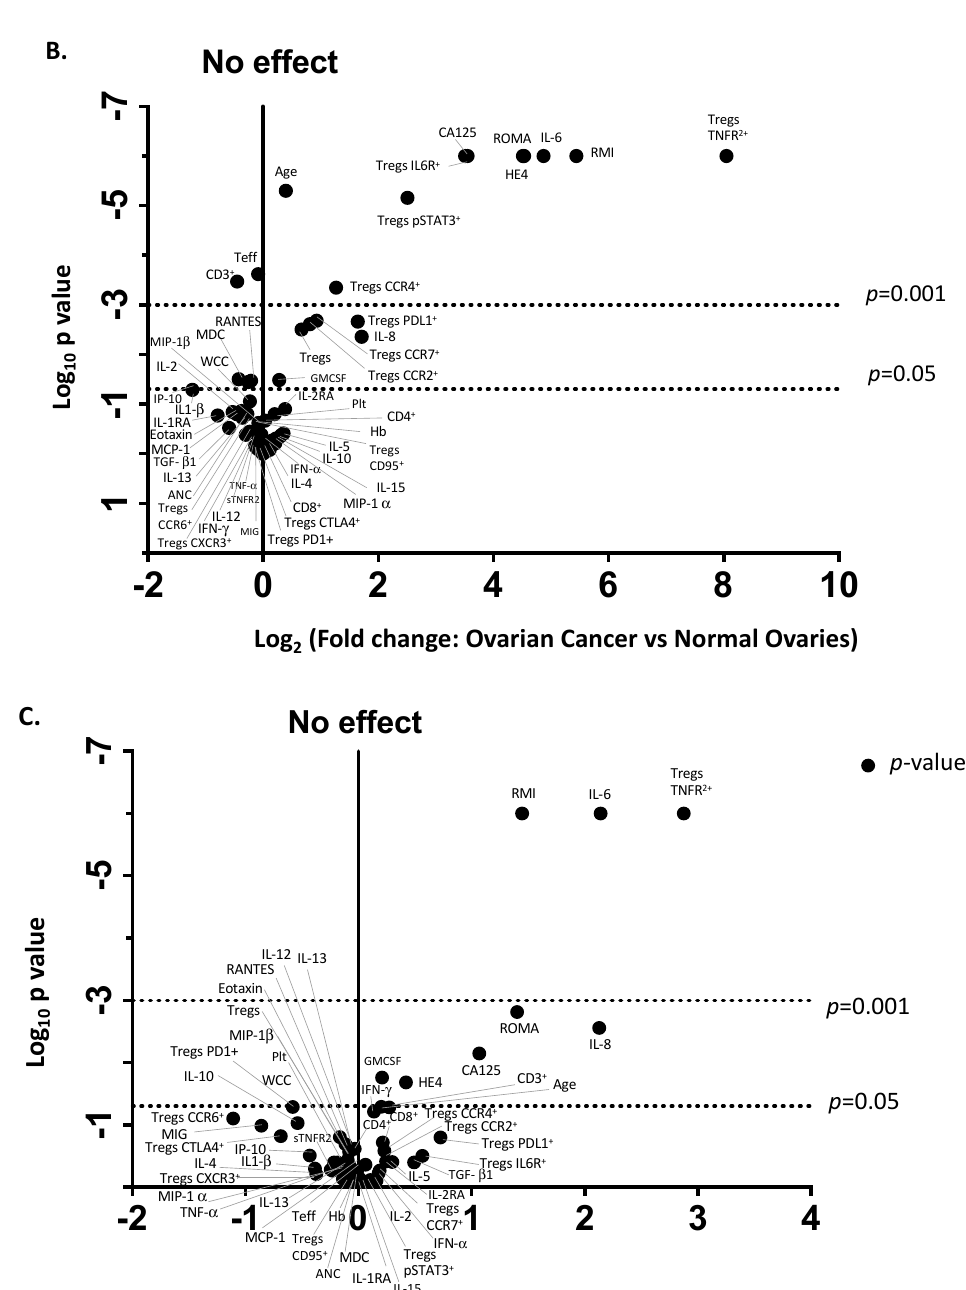
Figure 3. Volcano plot for the identification of discriminating biomarkers. Pre-treatment blood was withdrawn from 33 patients with ovarian cancer, 12 with benign ovarian mass and 21 with normal ovaries. A total of 28 serum-soluble factors measured using multiplex bead immunoassay and 16 phenotypic markers on Tregs and Teff quantified by flow cytometry as well as demographic data, blood components, serum CA125 and HE4 were included in analysis. Each circle corresponds to one study factor. The figure represents the negative log 10 p -values plotted against the log 2 -fold change of study factors, namely, the difference between two groups: ( A ) cancer versus benign ovarian mass, ( B ) cancer versus normal ovaries and ( C ) benign versus normal ovaries. Study factors with contrasts greater than a 2-fold change or with a p -value < 0.05 are labelled. ROC (receiver operator characteristic) analysis of TNFR2 + Tregs and IL-6 was per- formed to evaluate their predictive ability to distinguish ovarian malignancy compared